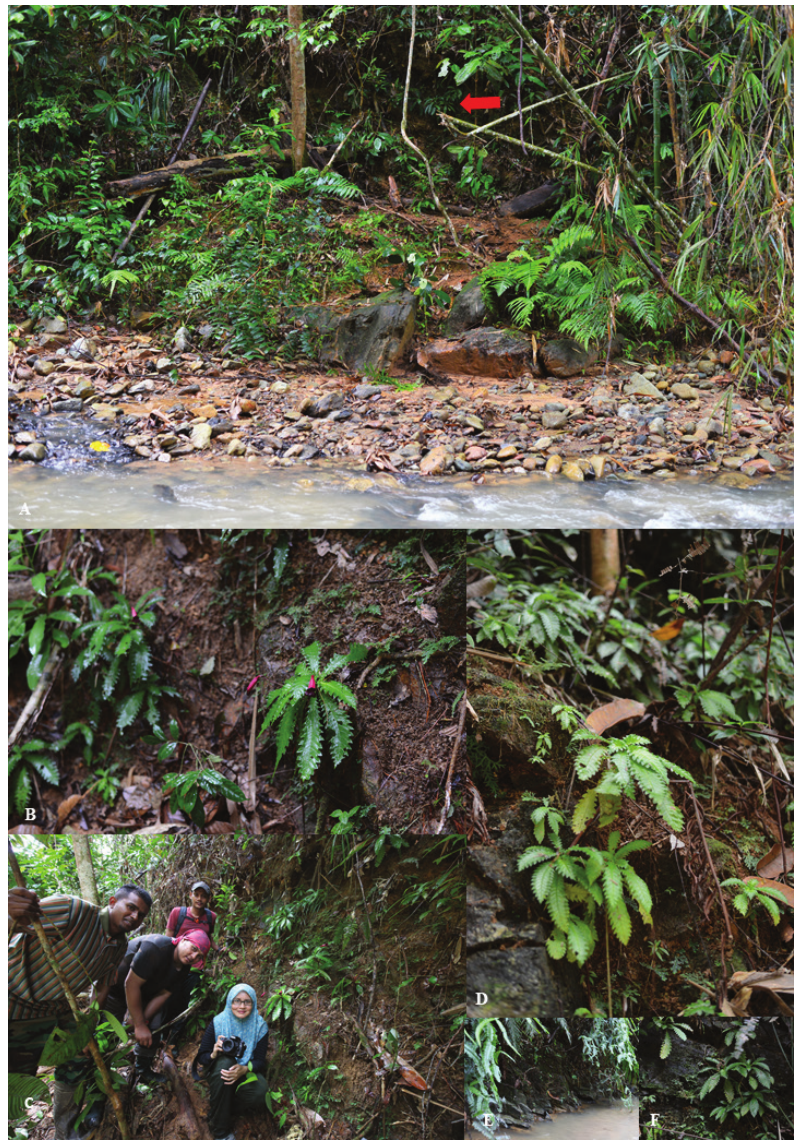
Figure 1. Habitat of Ridleyandra merohmerea . A habitat beside the river (plant show by red arrow) B plant habit C from left; Zaharil D, Mohd Hairul MA, Wan Syafik WP & Siti-Munirah MY; beside the habitat of Ridleyandra merohmerea D–F occurs on steep slope and some on rocks just beside the river (Photo by A–B, D–F Siti-Munirah MY C Zaharil